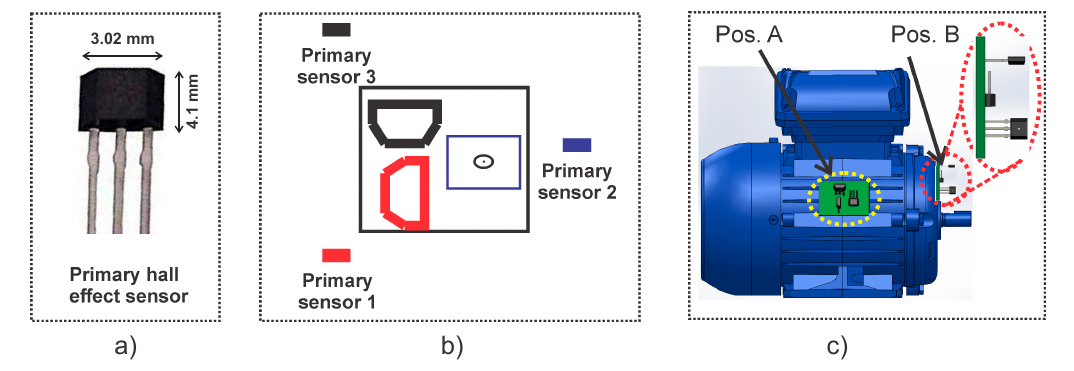
Figure 6. Triaxial stray flux sensor for data acquisition: ( a ) primary hall–effect sensor; ( b ) composition of the triaxial stray flux sensor; ( c ) triaxial stray flux sensor installation.